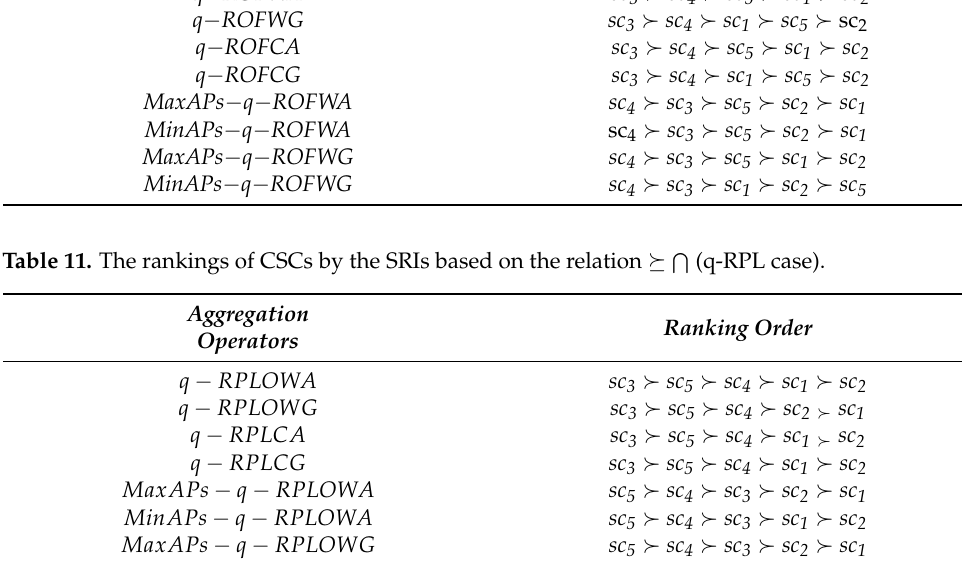
Table 10. The rankings of CSCs by the SRIs based on the relation (cid:23) (cid:84) (q-ROF case). Aggregation Operators